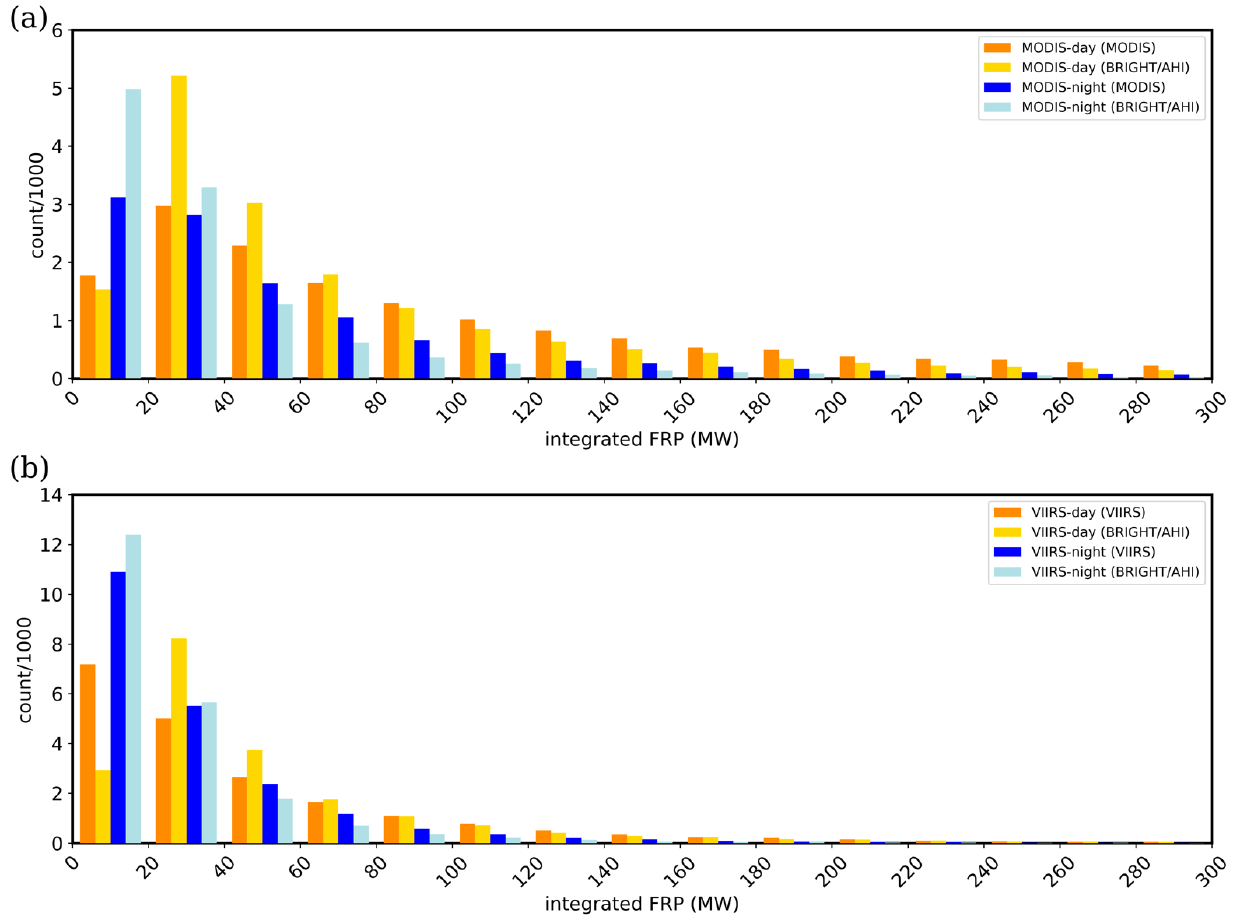
Figure 2. ( a ) Counts of non-saturated matched hotspots stratified by FRP value (in 20 MW bins) for MODIS-day (MODIS) (orange), MODIS-night (MODIS) (dark blue), MODIS-day (BRIGHT/AHI) (yellow), and MODIS-night (BRIGHT/AHI) (light blue). ( b ) Same but for VIIRS datasets. Table 2. Number of non-saturated matched hotspots in year-long Australia-wide sample, along with the respective number of matched hotspots with FRP > 300 MW (in terms of count and percentage of the total count), where polar means MODIS or VIIRS, and geo means BRIGHT/AHI. Total (Count) Polar > 300 MW (Count)